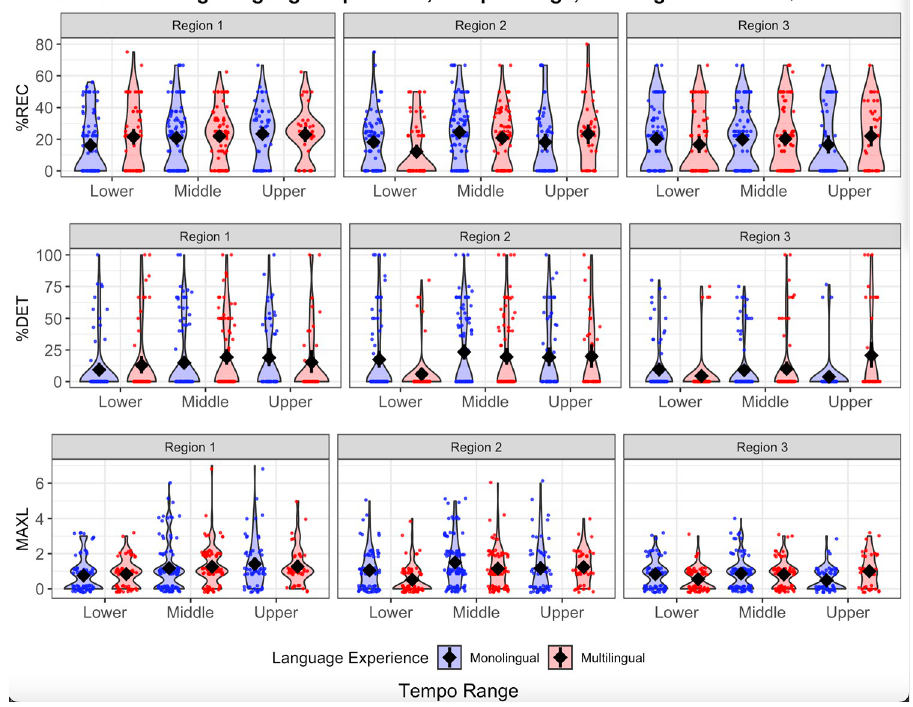
Fig 5. Effects of language experience (red: Multilingual; blue: Monolingual), tempo range, and region on MdRQA metrics: %REC (Panel A, top), %DET (Panel B, middle), and MAXL (Panel C, bottom). The metronome ranged from 80–140 bpm. In our linear mixed effects model, we binned tempo into the following categories: lower (80–90 bpm), middle (100–120 bpm), and upper (130–140 bpm). The violin plots depict the probability density of the binned tempo data at different %REC, %DET, and MAXL values. The mean value is indicated by a diamond near the center of each violin. Results of statistical analyses are located in Table 4.